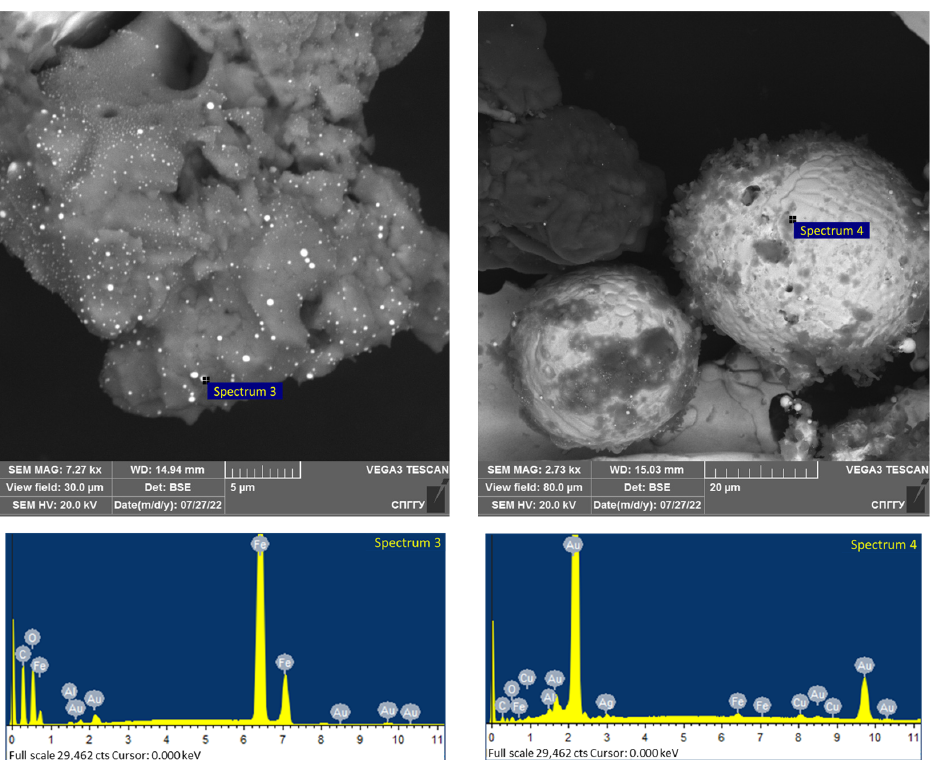
Figure 21. Results of the investigation of the CGO flotation concentrates after microwave treatment. Table 15. Elemental composition of the spectrum for the samples presented in Figures 20–22.